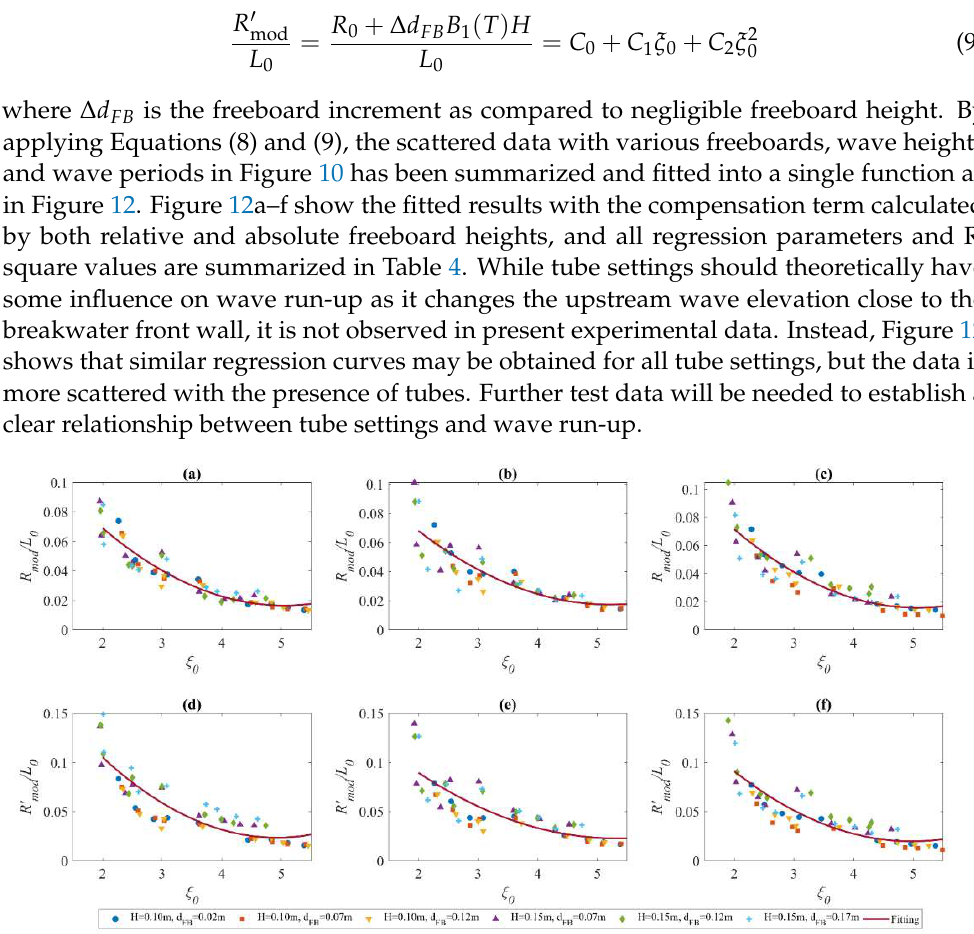
Figure 12. Relationship between modified normalized run-up and Iribarren number, using curve fit with Equation (8): ( a ) Blocked tubes; ( b ) Straight tubes; ( c ) Curved tubes and with Equation (9): ( d ) Blocked tubes; ( e ) Straight tubes; ( f ) Curved tubes. Table 4. Regression Coefficients of Curve Fitting in Figure 12. Fitted Curve